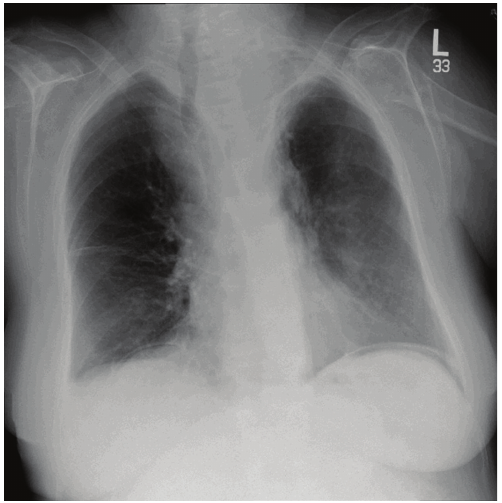
Figure 1: Upright chest plain radiograph (X-ray) showing free air (gas) under